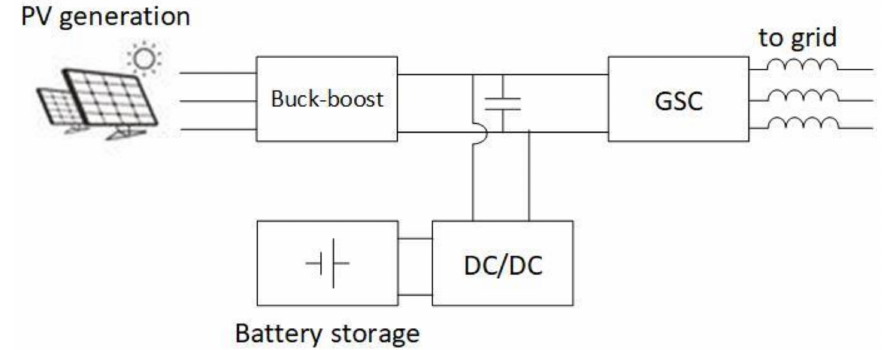
Figure 9. Schematic diagram of double-stage photovoltaic (PV) generation with energy storage on a direct current (DC)